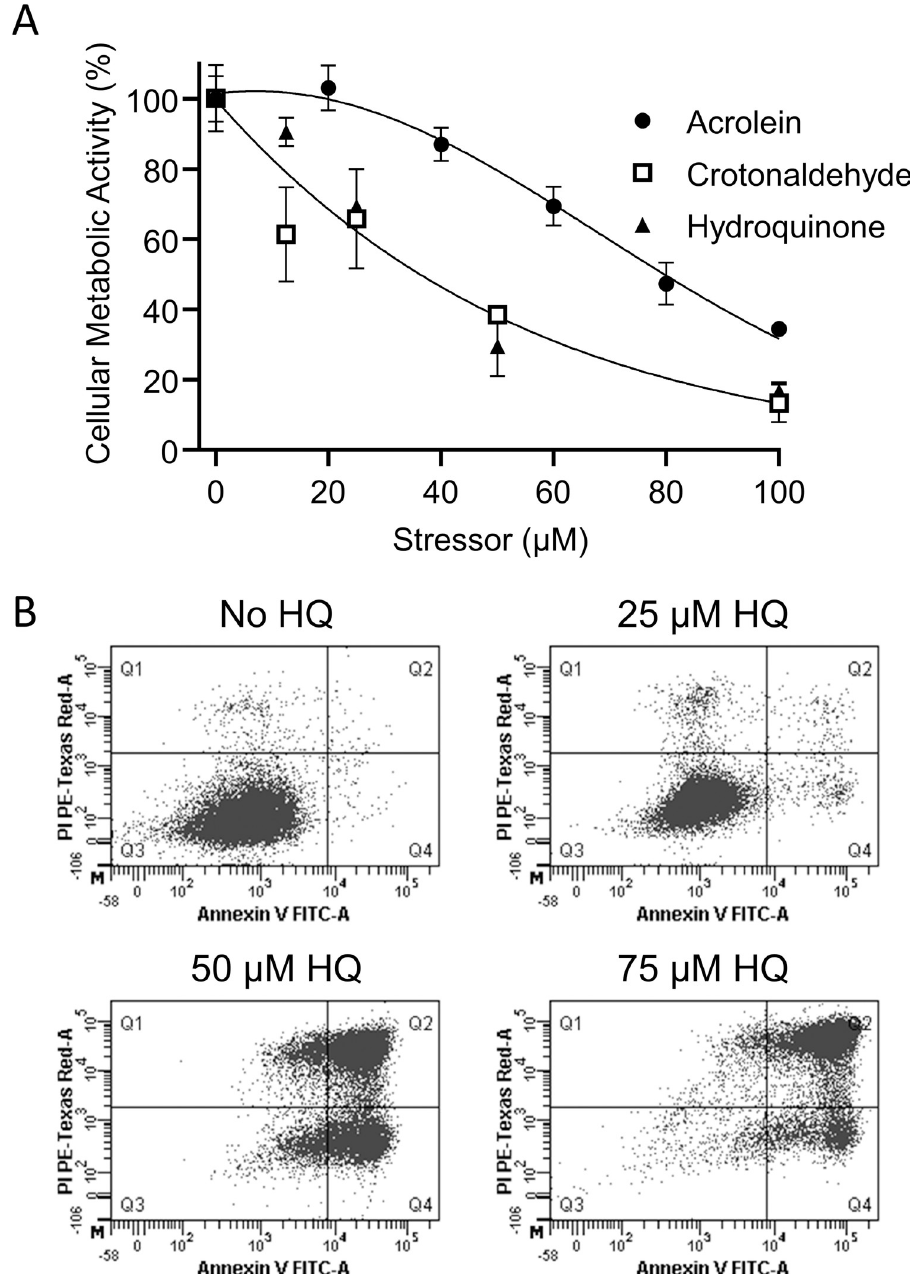
Fig 1. Viability of HEK 293AD cells in the presence of main smoke constituents. A) Cells were treated with indicated concentrations of acrolein, crotonaldehyde or hydroquinone (HQ). After 24 h incubation at 37 ˚C the levels of cellular metabolic activity were determined by MTT assay as described in Materials and Methods. Values are expressed as percent of untreated cells. Data points represent the average of two or three independent experiments with SD. B) Cells were exposed to indicated concentrations of HQ. After 24 h incubation at 37 ˚C, cells were stained with FITC annexin V and propidium iodide, and analyzed by flow cytometry as described in Materials and Methods. Fluorescence of FITC annexin V and propidium iodide are shown on the x and y axes, respectively. Representative pictures of three experiments are shown.